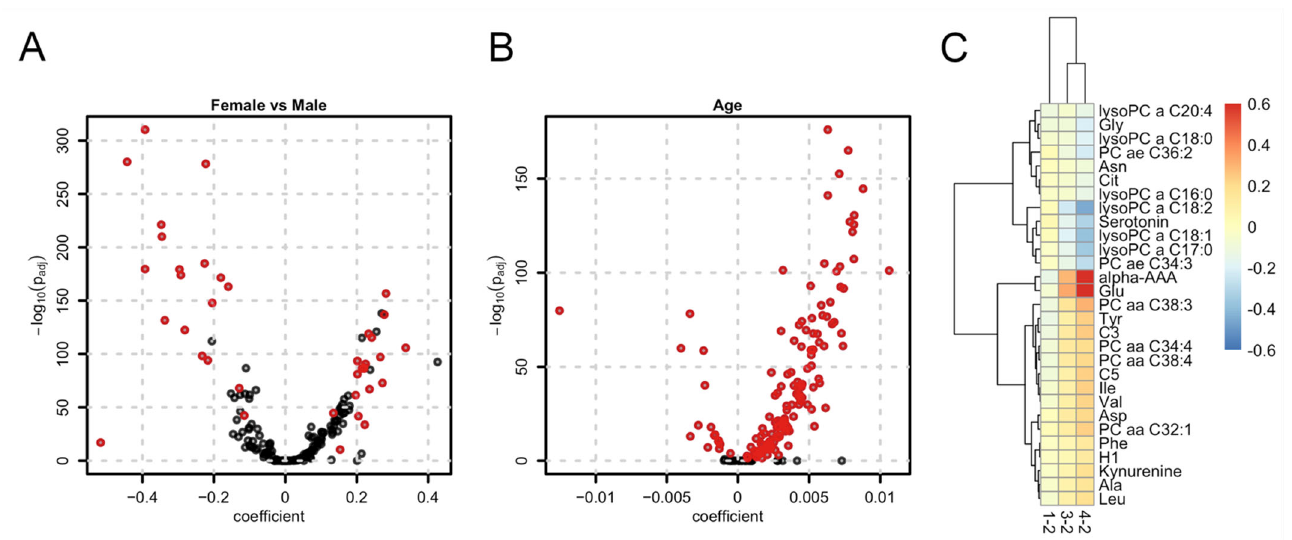
Figure 1. Sex ‐ , age ‐ and BMI ‐ related metabolites. ( A ) Volcano plot for the differential abundance of metabolites between females and male participants. The coefficient represents the log2 ‐ difference in average concentrations between the groups; ( B ) Volcano plot for age dependency of metabolites. The coefficient represents the log2 ‐ change of concentration per year; ( C ) Heatmap of coefficients for metabolites found to be significant for at least one BMI category. The coefficient represents the average log2 ‐ difference in abundance between BMI categories 1, 3, and 4 compared to the reference category 2.